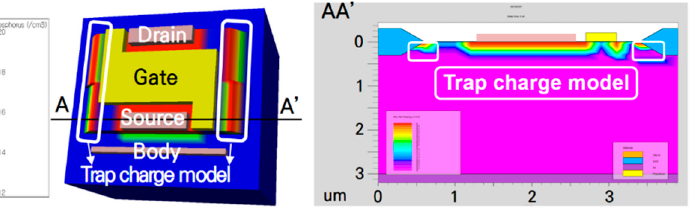
Figure 11. 3D radiation damage model for RH V-gate n-MOSFET and its cross-sectional view.